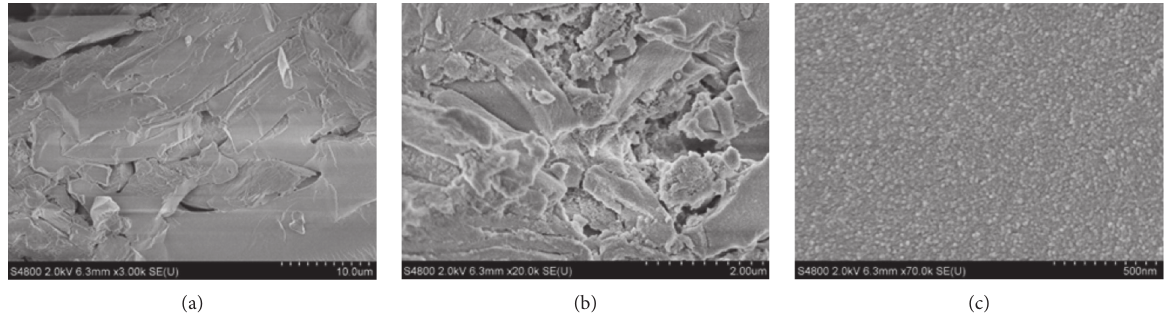
Figure 2: SEM images of samples in Shigetai Coal Mine at different magnifications (3000, 20000, and 70000x from left to right).